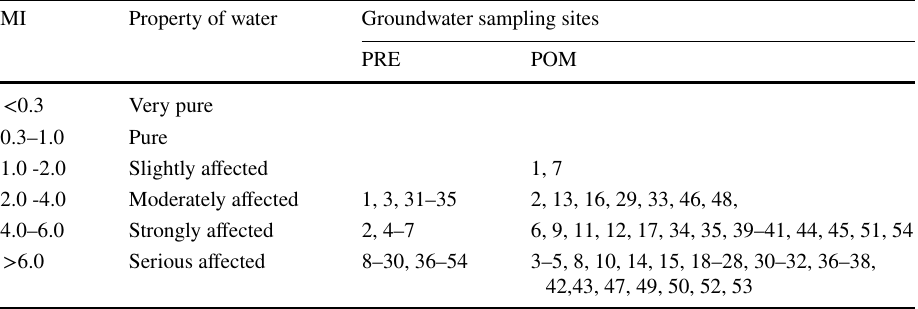
Table 6 Classification of the groundwater on the basis of metal